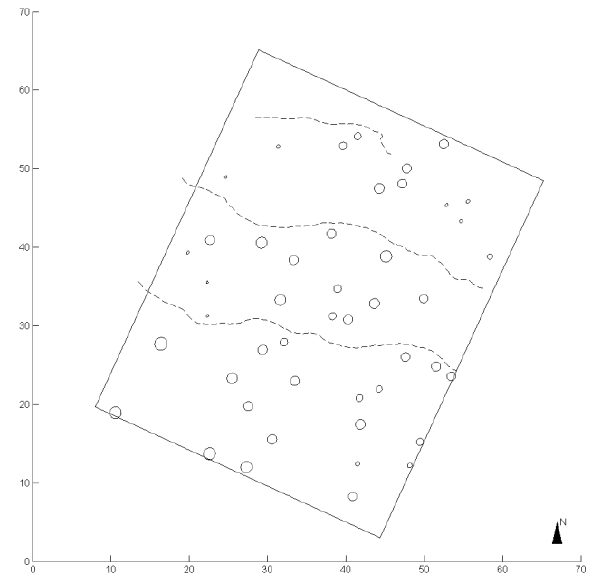
Figure 2. The test forest plot and the mapping paths in the data collection . The rectangular area presents the test plot boundary. The circles and their diameters show the tree locations and corresponding DBHs. The mapping paths are indicated by dashed